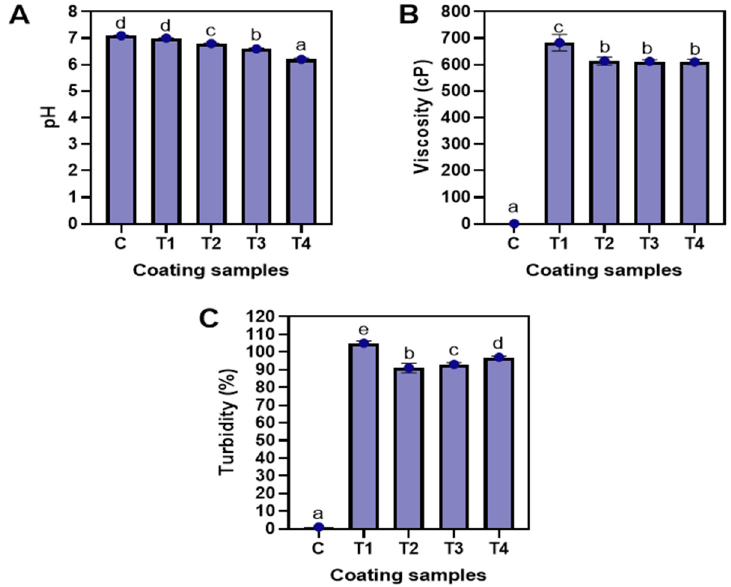
Figure 2. The pH ( A ), viscosity ( B ), and turbidity ( C ) of the alginate coating and alginate-based nanoparticle coating with different concentration of LPE. C: distilled water; T1: alginate coating; T2, T3, and T4: alginate-based nanoparticle coating with 0.5, 1.0, and 1.5% LPE, respectively. The different alphabets shown on the bar diagram indicate significant differences.